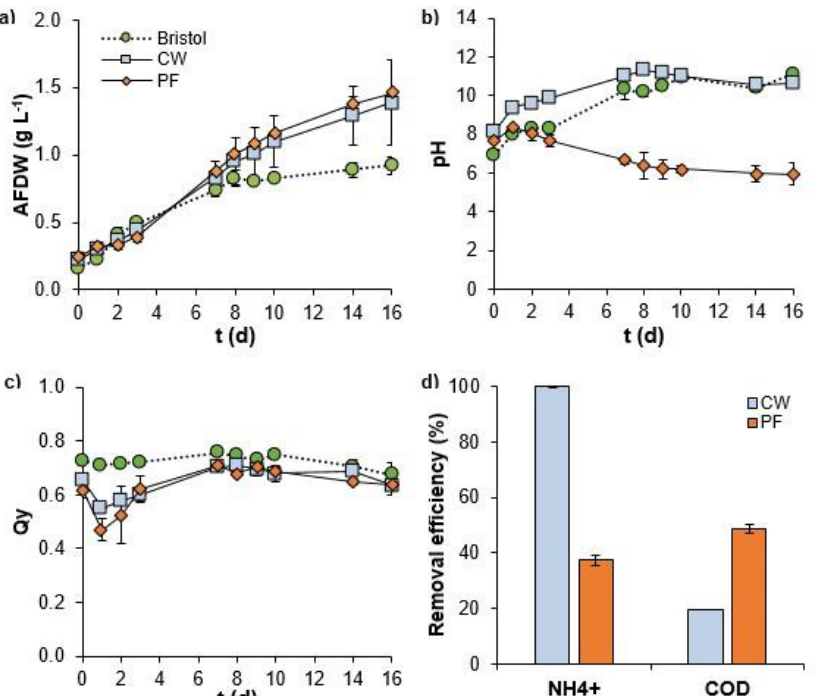
Figure 6. ( a ) Growth curve in ash-free dry weight (AFDW), ( b ) pH, ( c ) quantum yield (Qy), and ( d ) Removal efficiency of ammonia (NH 4+ ) and chemical oxygen demand (COD) of Tetradesmus obliquus cultivation in piggery wastewater pretreated by photo-Fenton (PF) and constructed wetland (CW). Bristol medium was used as the control. Values are presented as the mean ± mean deviation ( n = 2).